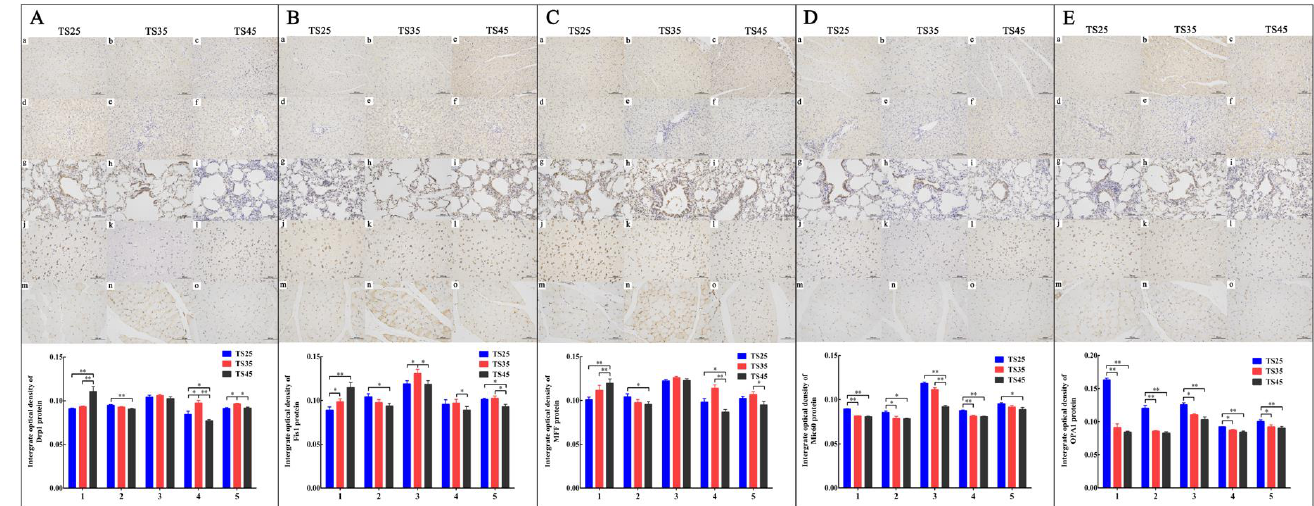
Figure 7. Immunostaining of mitochondria fission (Drp1 ( A ), Fis1 ( B ), MFF ( C )) and fusion (Mic60 ( D ), OPA1 ( E )) proteins in five tissues of Tibetan sheep (20×). ( a – c ) Heart. ( d – f ) Liver. ( g – i ) Lung. ( j – l ) Brain. ( m – o ) Quadriceps femoris. ( 1 – 5 ) Heart, liver, lung, brain, quadriceps femoris. ( TS25 ) 2500 m altitude Tibetan sheep. ( TS35 ) 3500 m altitude Tibetan sheep. ( TS45 ) 4500 m altitude Tibetan sheep. Date shown on graph are means ± SEM. The IOD in heart of TS25 as control, * p < 0.05, ** p < 0.01.